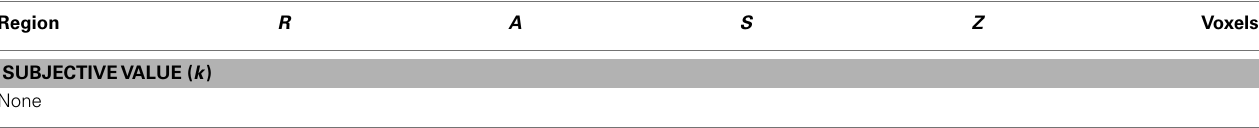
TableA2 | No age differences emerged in regions representing subjective value using a hyperbolic model of discounting (older > younger).